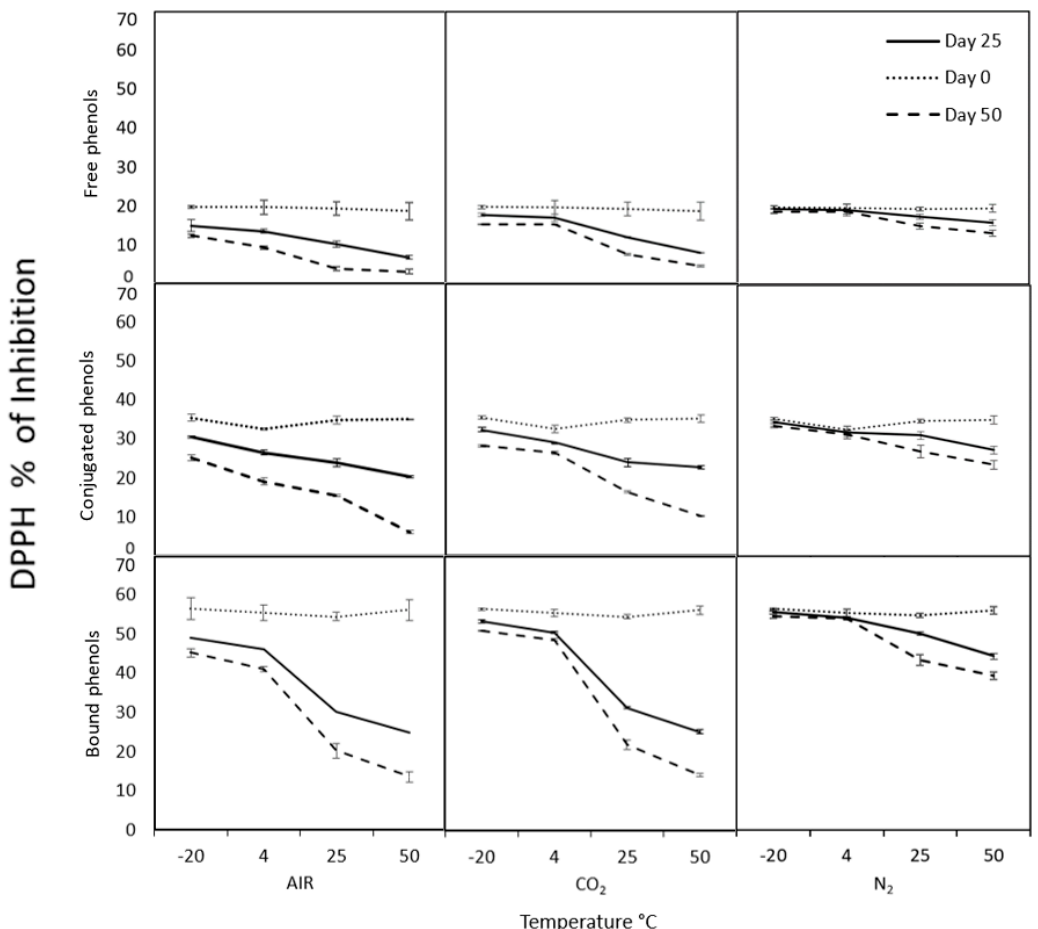
Figure 2. Antioxidant capacity by radical DPPH of free, conjugated and bound phenols under different storage conditions. Control was air treatment.